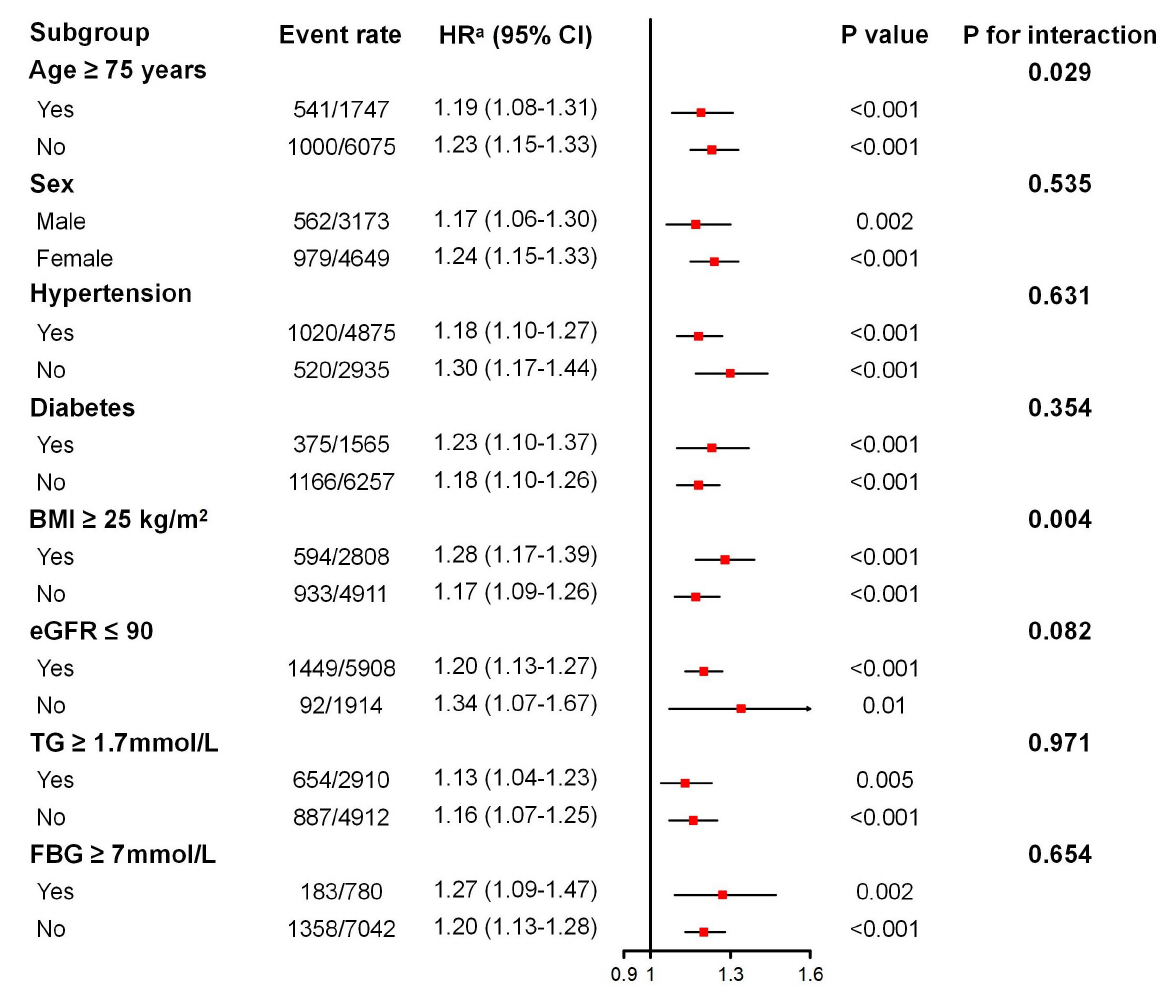
FIGURE2 Subgroup analysis of the association between the triglyceride–glucose index and incident chronic kidney disease. BMI, body mass index; eGFR, estimated glomerular filtration rate; TG, triglyceride; FBG, fasting blood glucose. Adjusted for age, sex, systolic blood pressure, diastolic blood pressure, BMI, waist circumference, baseline eGFR, total cholesterol, exercising daily, drinking daily, and currently smoking for diabetes and fasting blood glucose subgroups. Adjusted for age, sex, diabetes mellitus, systolic blood pressure, diastolic blood pressure, BMI,